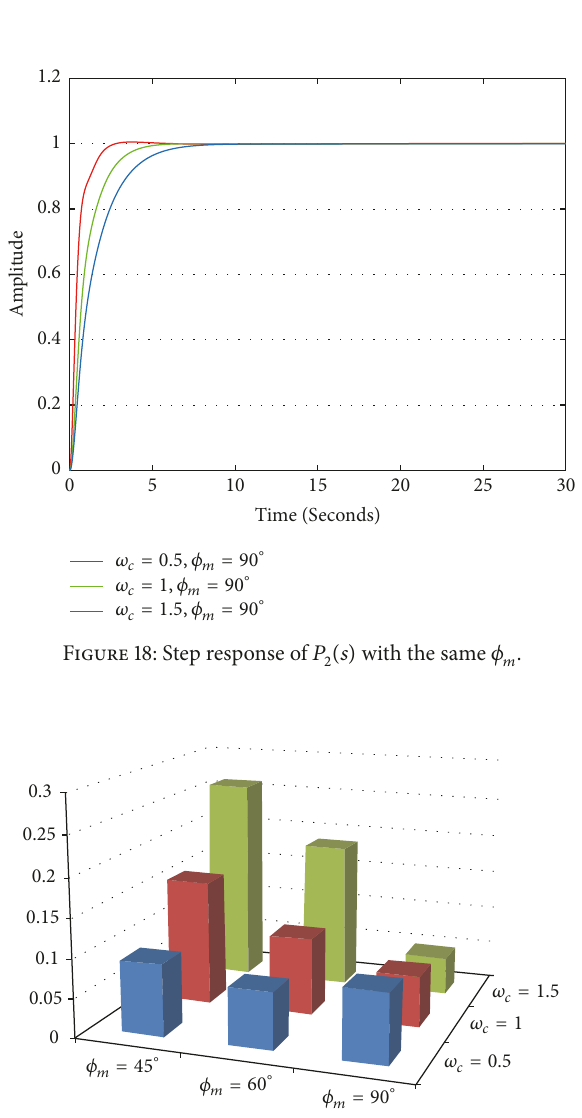
Figure 19: ITAE indices values of 𝑃 2 (𝑠) .